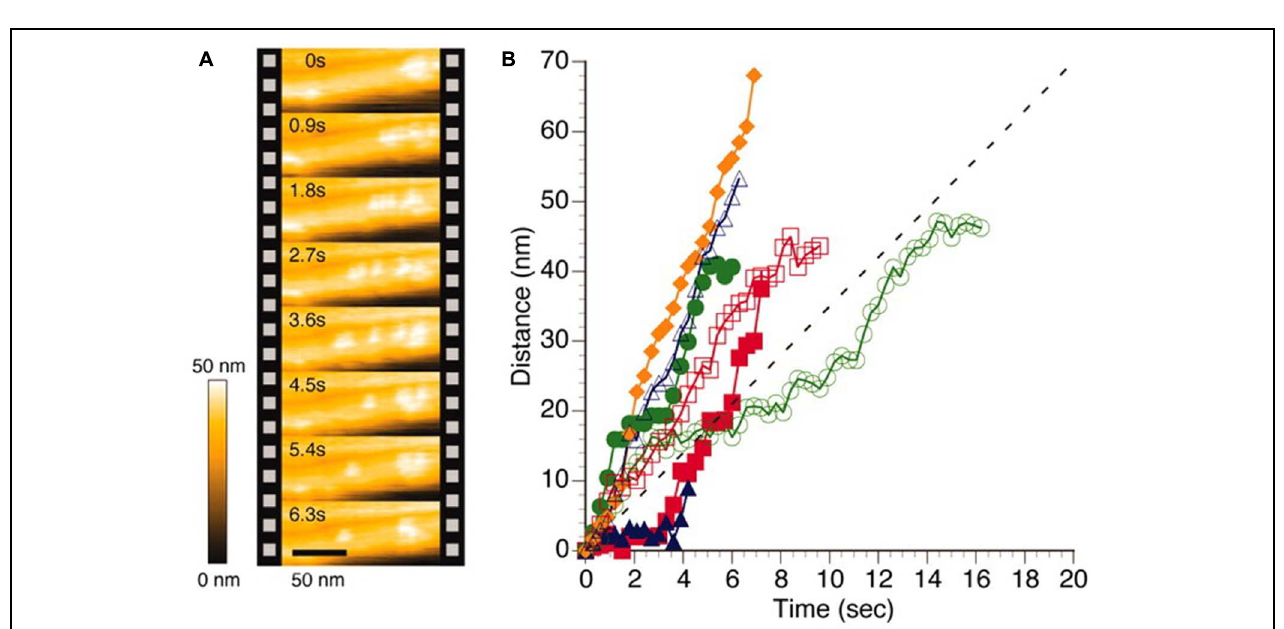
at room temperature and treated at 44 ◦ C for 30 min (A) and following annealing for 30 min at a temperature of 90 ◦ C (B). Reproduced with with permission from Maurstad and Stokke (2004). Copyright (2004) Wiley.